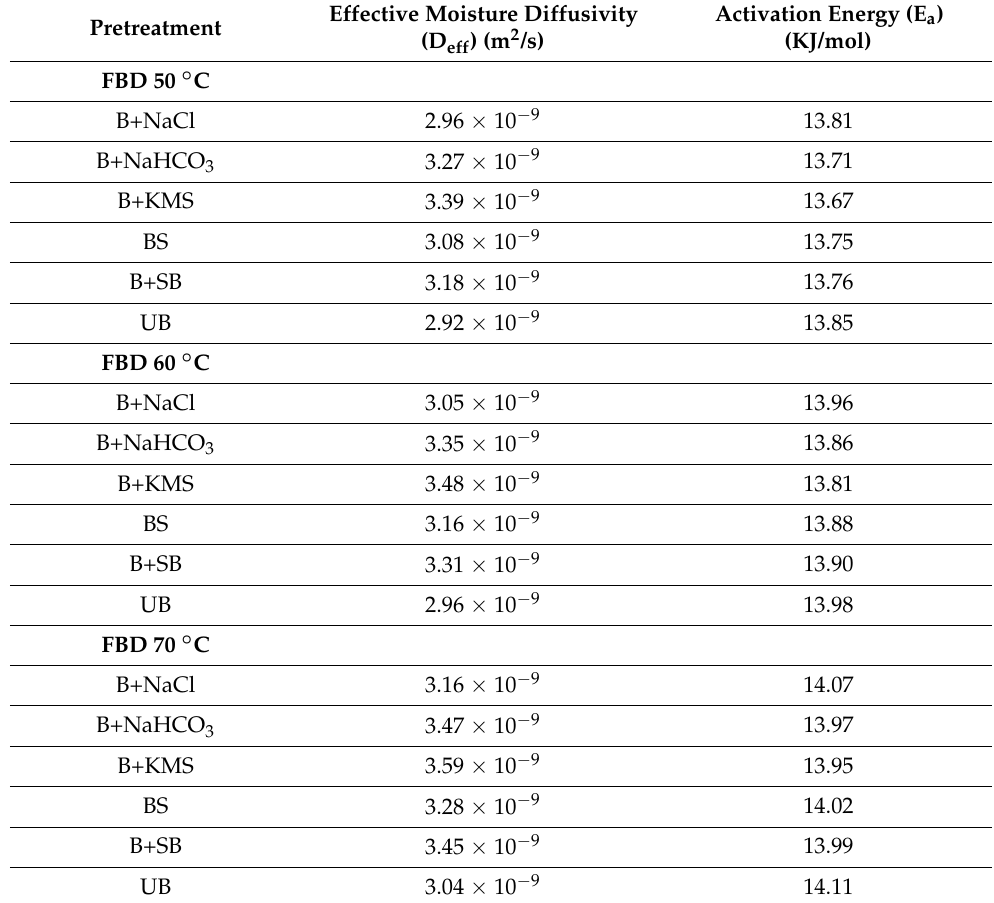
Table 5. Effective moisture diffusivity (D eff ) and activation energy (E a ) of fluidized bed-dried drumstick